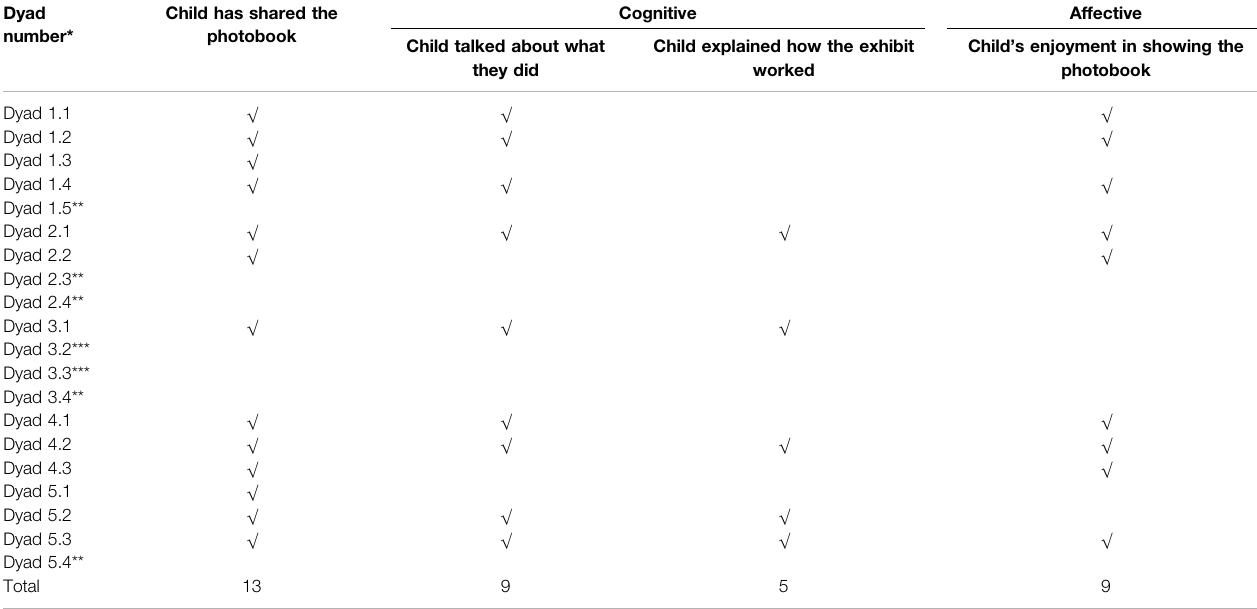
TABLE 4 | Classi fi cation of parents ’ description of how their children had used the photobooks at home. Dyad Child has shared the Cognitive Affective number* photobook Child talked about what Child explained how the exhibit they did